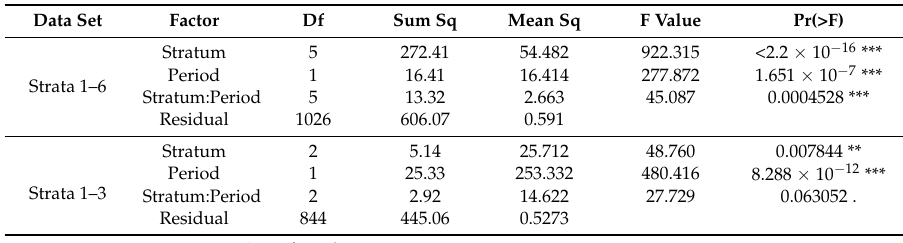
Table A5. Two-way ANOVA with interaction. Variables: Per capita consumption.